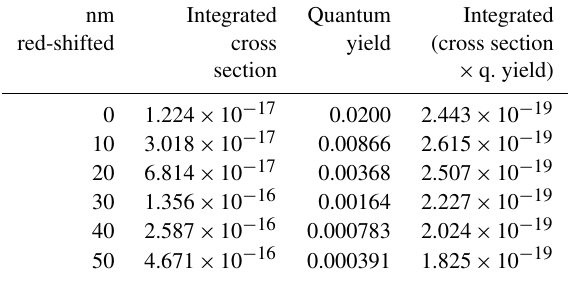
Table 3. Quantum yield estimation for the photolysis process stud- ied as variation of the red shift of the cross section (from 250 to 400nm) obtained for the ammonium iodate